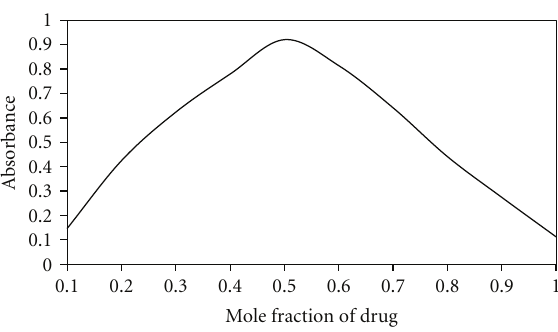
Figure 2: Continuous variation plot for the reaction of alendronate sodium and color producing